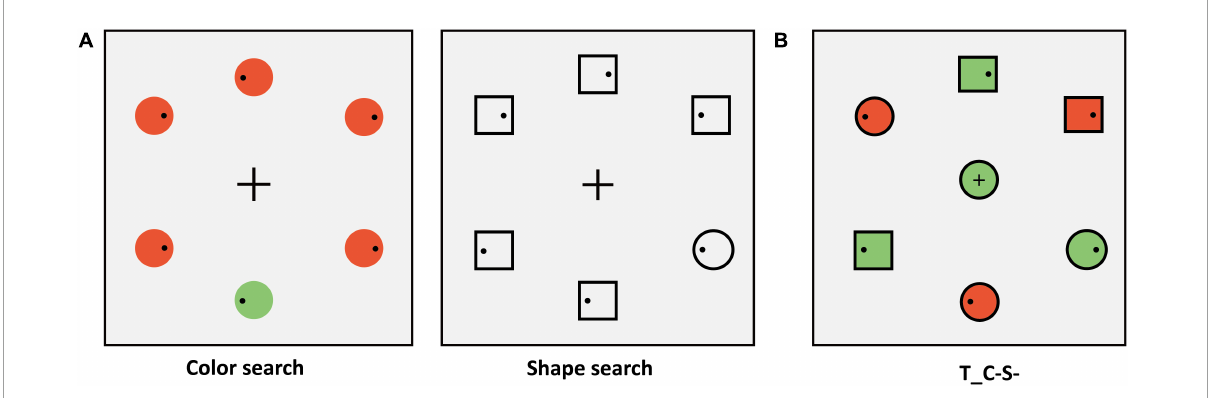
FIGURE6 (A) Schematic search display of the matching phase (e.g., target: green circle). The schematic procedure of the matching phase was shown in Figure 3 . (B) Schematic one of the center stimuli conditions, the other conditions, and the Schematic procedure of the search task phase were similar to that in Experiment